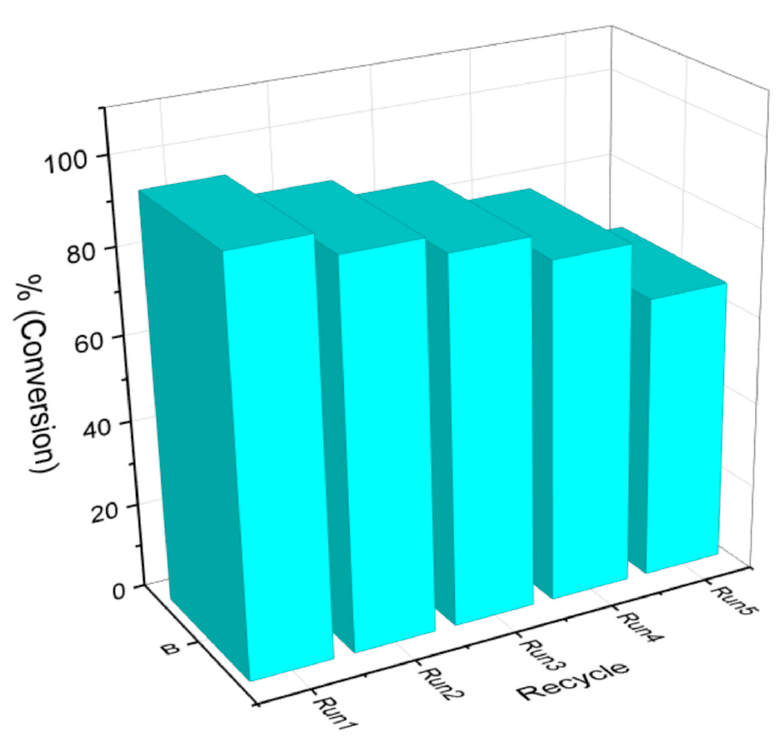
Figure 8. Reusability study of the Pt@ZIF-67 catalyst.